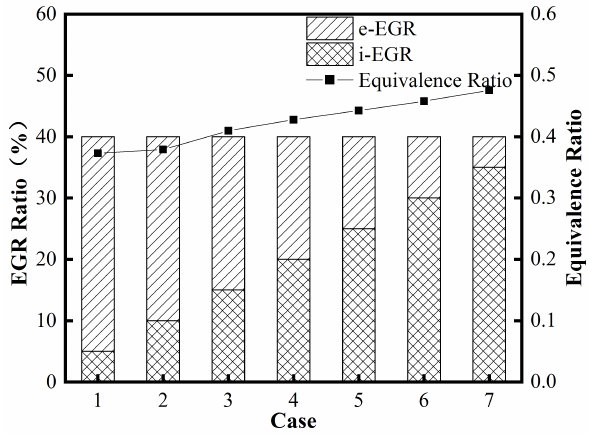
Fig. 13 Effect of i-EGR ratio and e-EGR ratio on equivalence